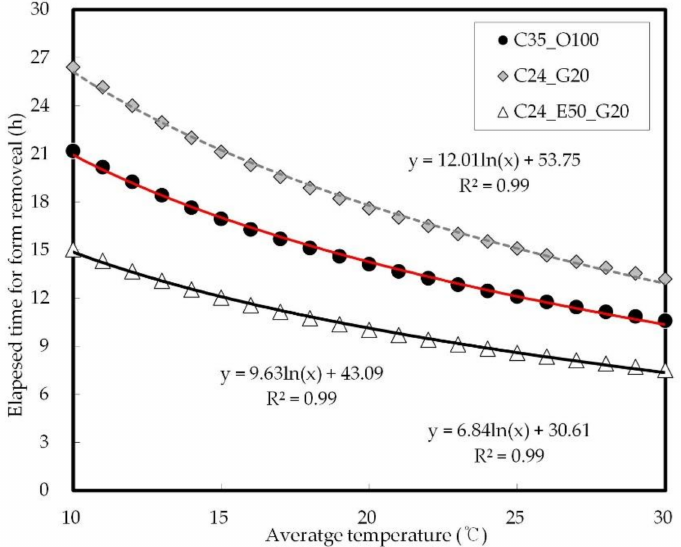
Figure 18. Prediction of elapsed time at a strength of 5 MPa on concrete according to curing